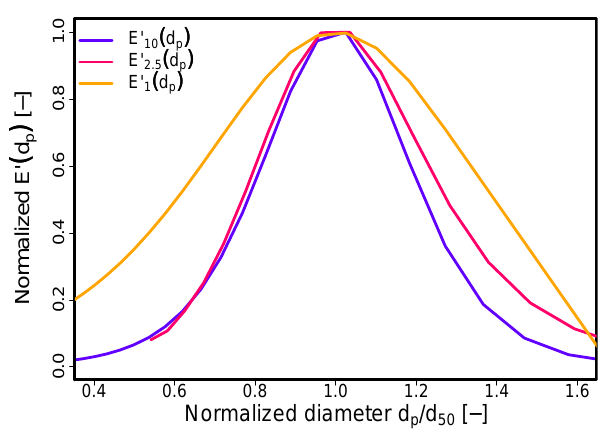
Fig. 5. Experimental RDI cutoff sharpness: normalized first deriva- tives of E i (cid:0) d p (cid:1) plotted versus the normalized diameter d p /d 50 ,i . The E curves represent a measure for the size-segregation sharpness in the